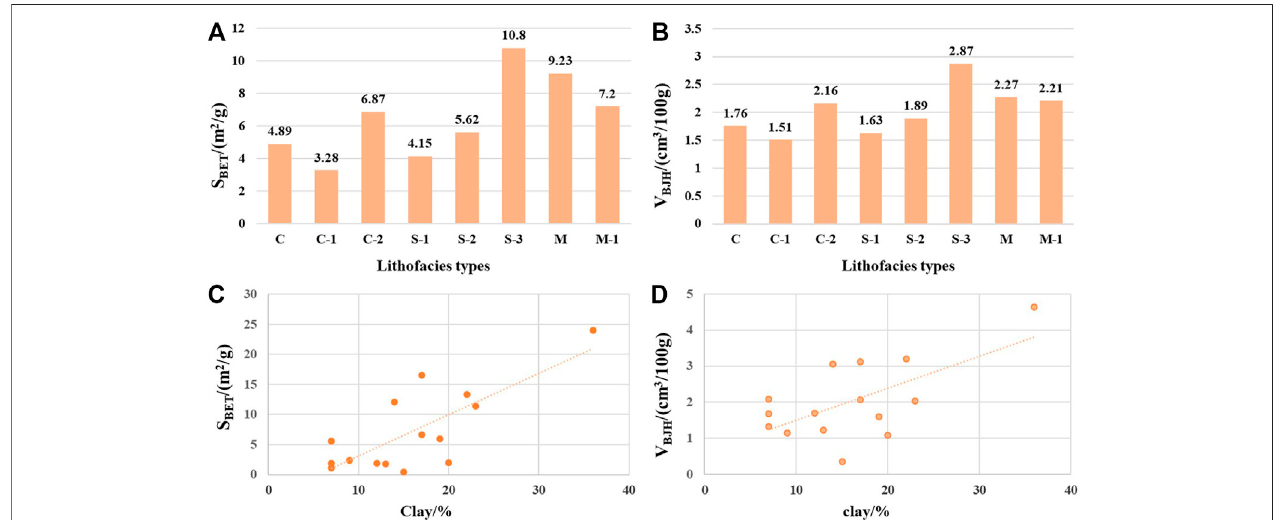
FIGURE11| Comparisonofnano-scaleporecharacteristicsofdifferentlithofaciestypes. (A) and (B) refertothevaluesofSandVofdifferentlithofacies. (C) and (D) refer to the correlation between clay minerals and nano-scale reservoir space (S, V). C: Low organic matter (OM) — massive - carbonate shales. C1: Medium to high OM — laminated — siliceous carbonate shales. C2: Low to medium OM — layered — mixed carbonate shales. S1: Medium to high OM — laminated — carbonate siliceous shales. S2: Medium to high OM — massive — mixed siliceous shales. S3: Medium to high OM — laminated — argillaceous siliceous shale. M: Low to medium OM — massive -mixed shale. M1: Medium to high OM — laminated — mixed shale.